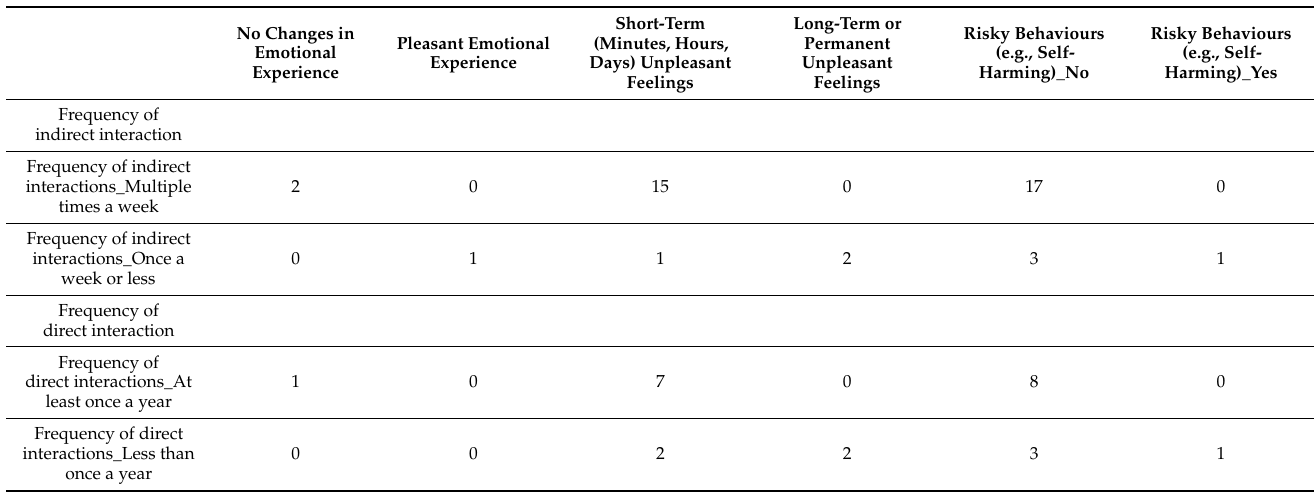
Table A2. Changes on children by frequency of direct and indirect interaction with the migrating parent(s) child carer.